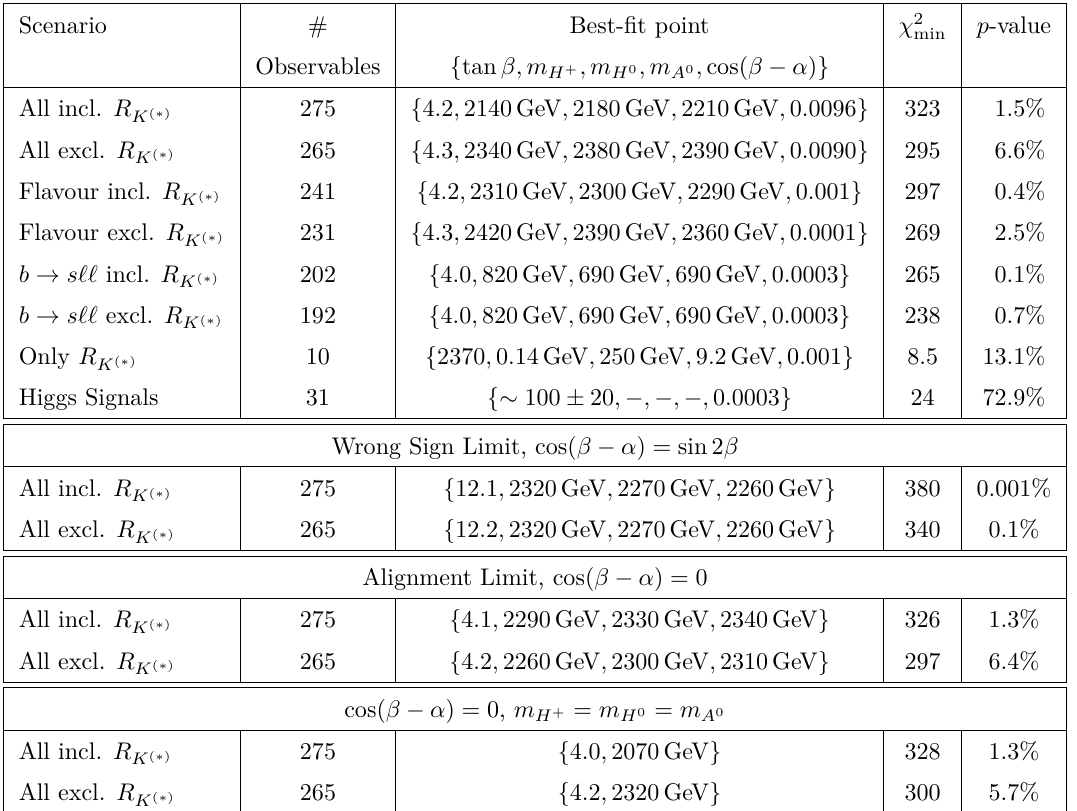
Table 2. Best fit points of 2HDM-II parameter fits for various groups of observables using the constraints from theory to inform the physical parameter